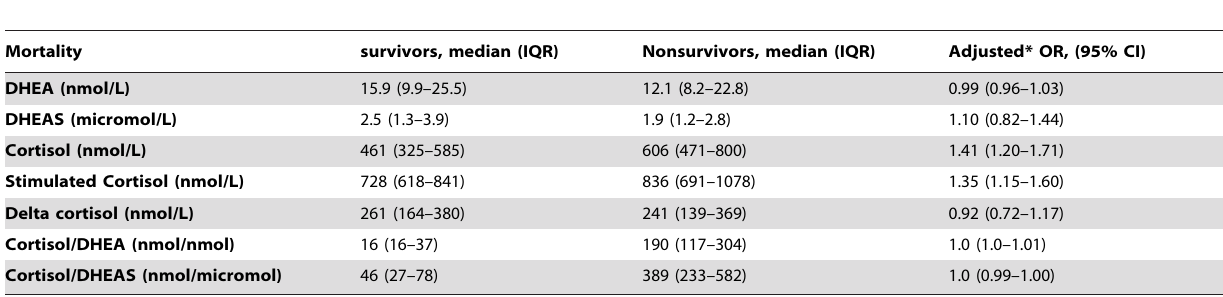
Table 3. Prognostic value of DHEA, DHEAS, basal cortisol, stimulated cortisol, delta cortisol, and the ratios cortisol/DHEA and cortisol/DHEAS for mortality after 1